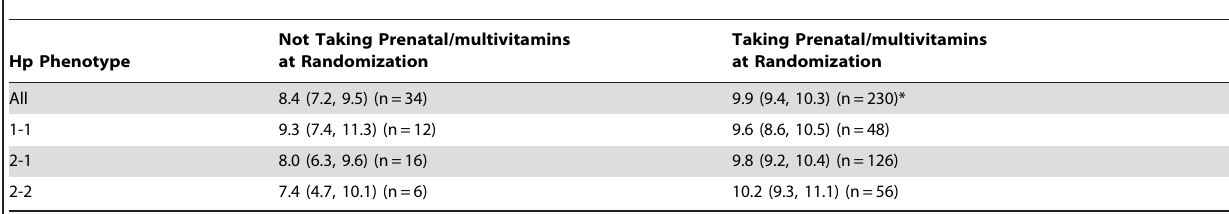
Table 5. Plasma ascorbate concentrations according to Hp phenotype and prenatal/multivitamin use at randomization.